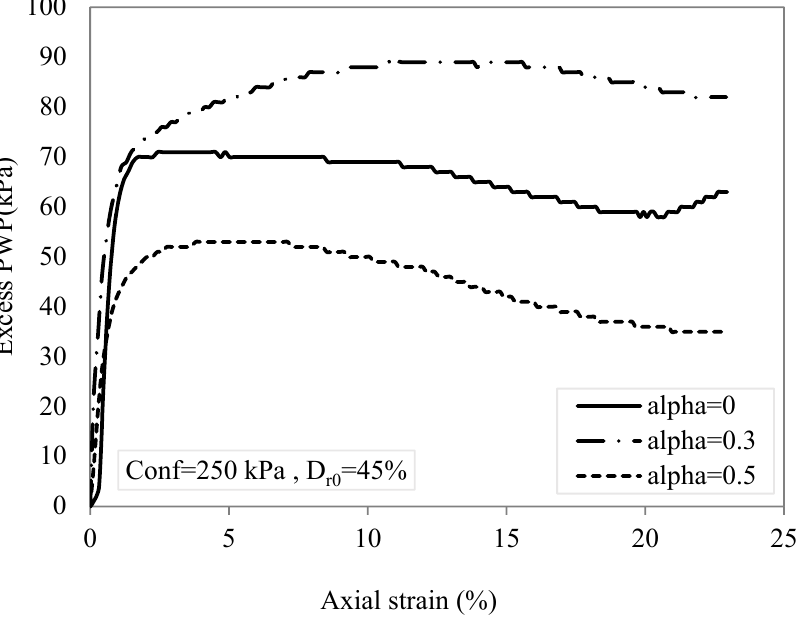
Figure 11. Comparative curvatures for (R–A) 6 , (R–B) 6 and (R–C) 6 in u– ε % plane. Alpha ( α ): the initial shear stress ratio.